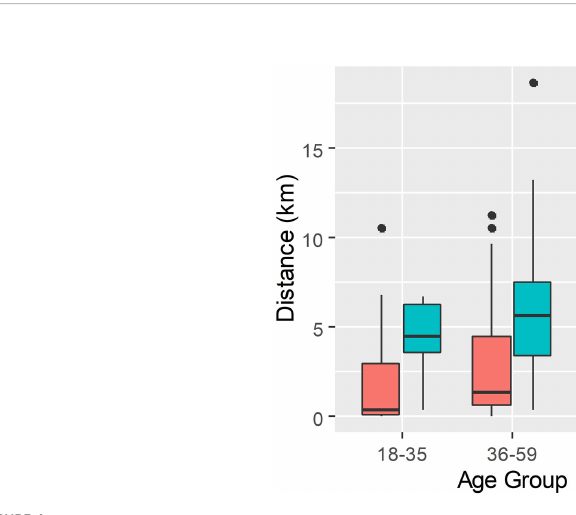
FIGURE 4 Distance fi shers travel to fi shing sites by age and